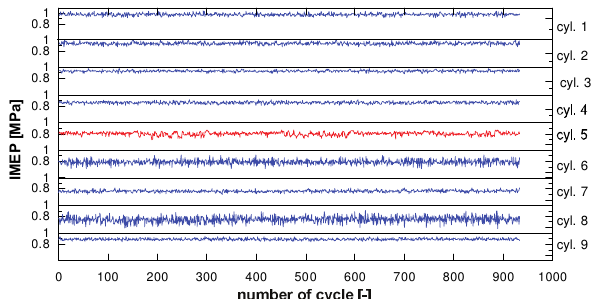
Fig. 7. IMEP time series in subsequent operating cycles when mixture composition was modified in cylinder